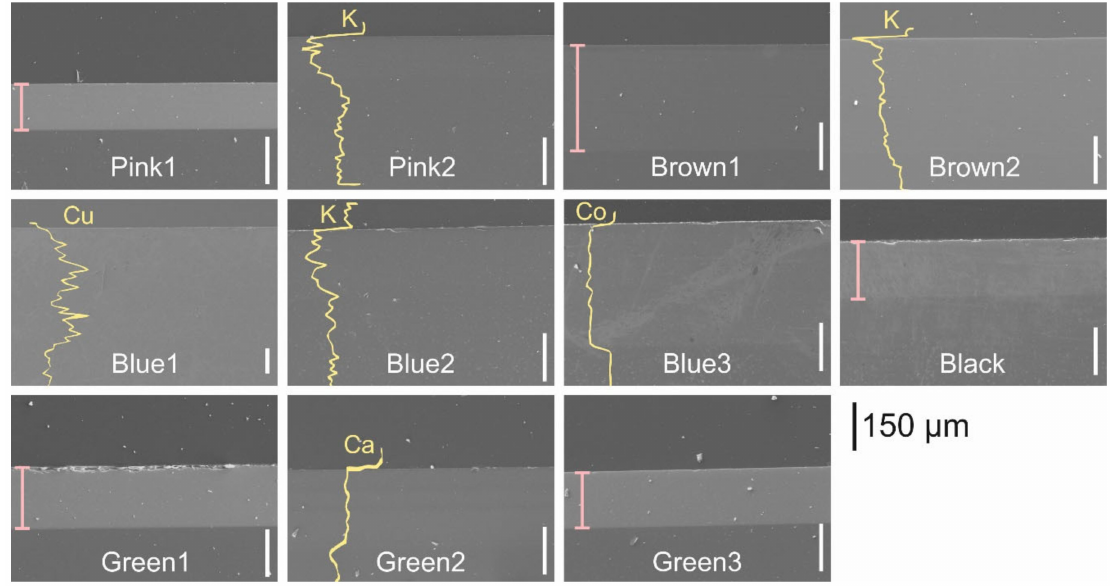
Figure 3. FESEM images of the colored layers in the flashed glasses in cross-section. The scale is the same for all the